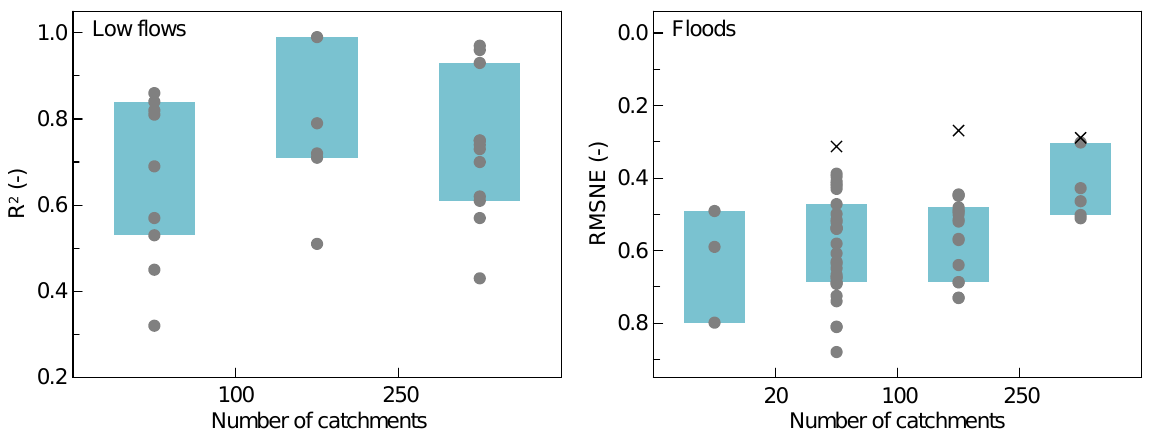
Fig. 4. Coefficient of determination of predicting low flows in ungauged basins (left) and root mean squared normalised error of predicting floods in ungauged basins (right), stratified by the number of catchments within each study (Level 1 assessment). Each symbol refers to a result from the studies in Tables 1 and 3. Circles represent performances calculated on specific discharges (m 3 s − 1 km − 2 ) , crosses represent performances calculated on discharges (m 3 s − 1 ) . Boxes show 25–75%